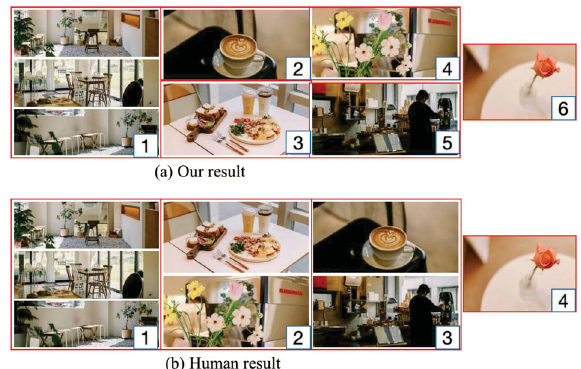
Fig. 11 Failure case of our method. Our result has low consistency with the human result.